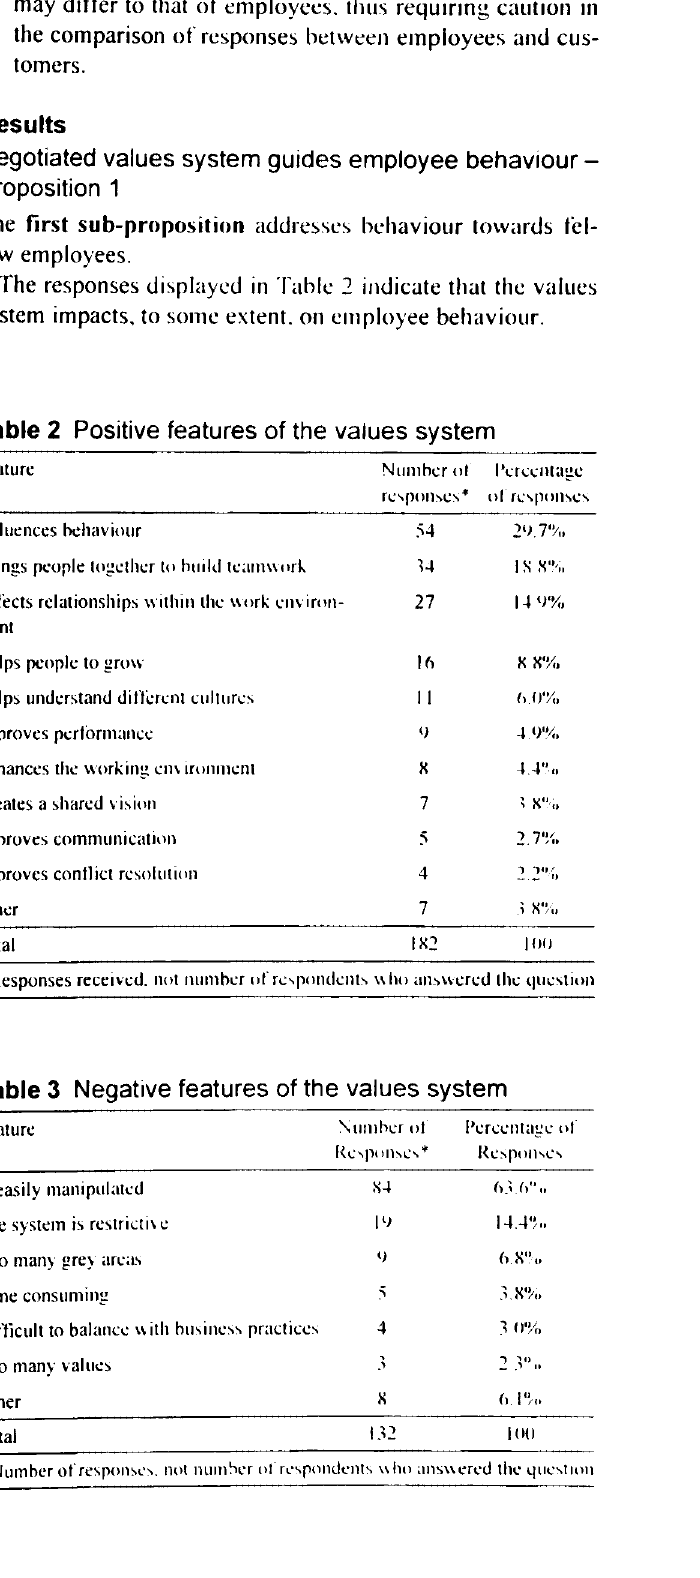
Table 3 Negative features of the values